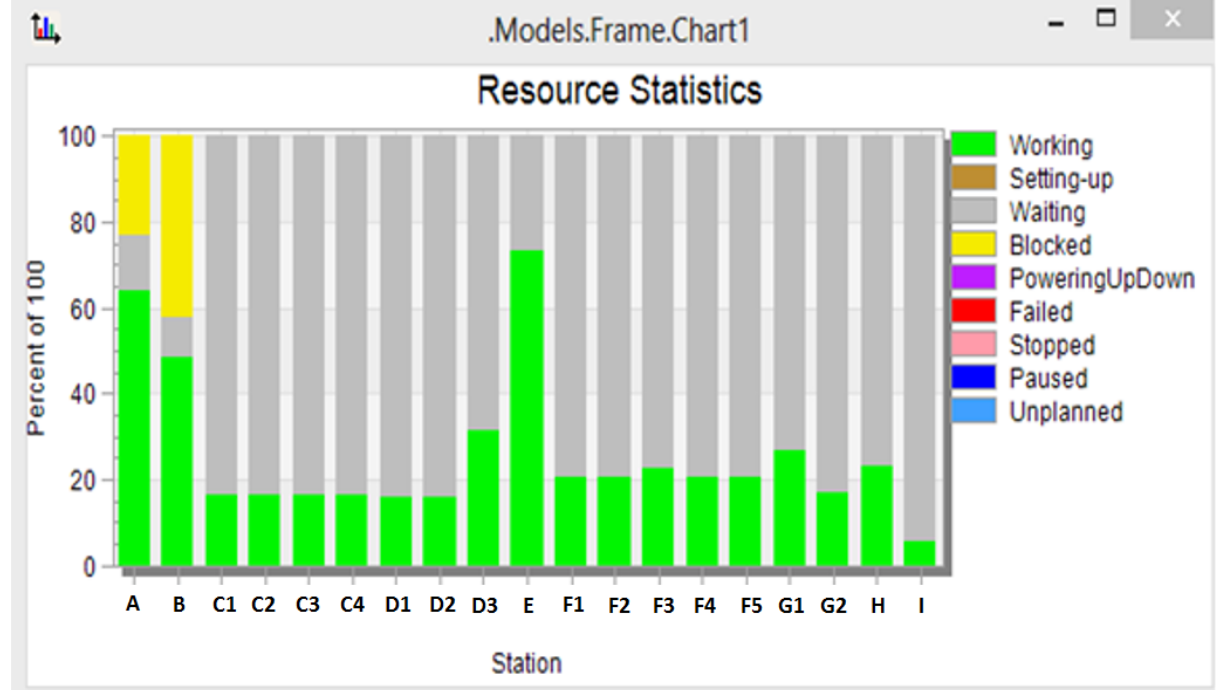
Figure 6: Capacity utilisation (time utilisation of technological operations) –